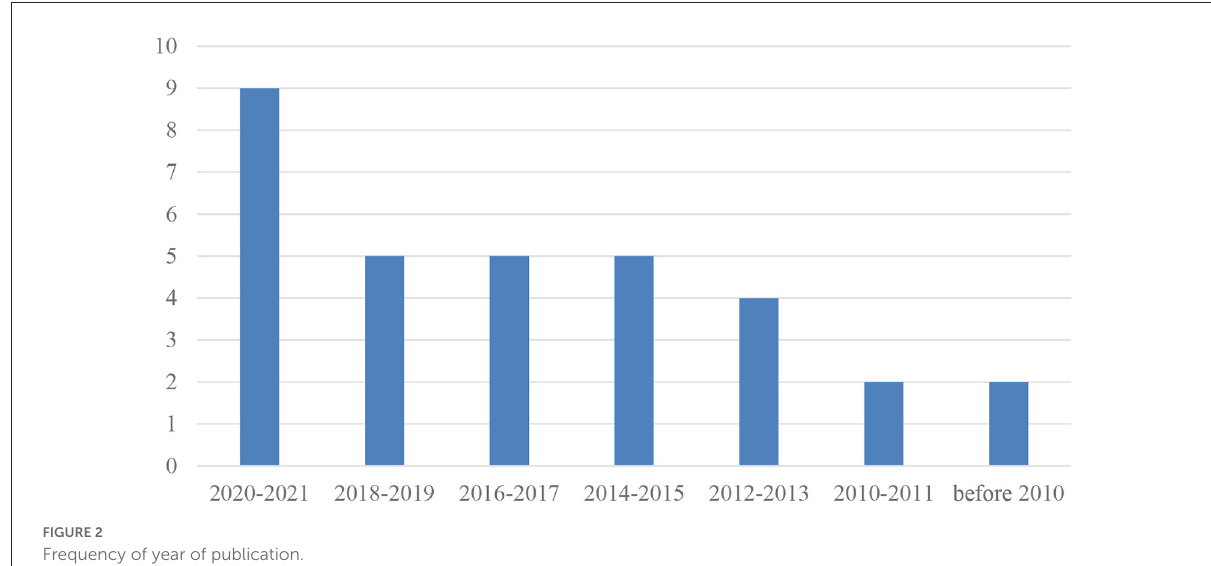
FIGURE2 Frequency of year of